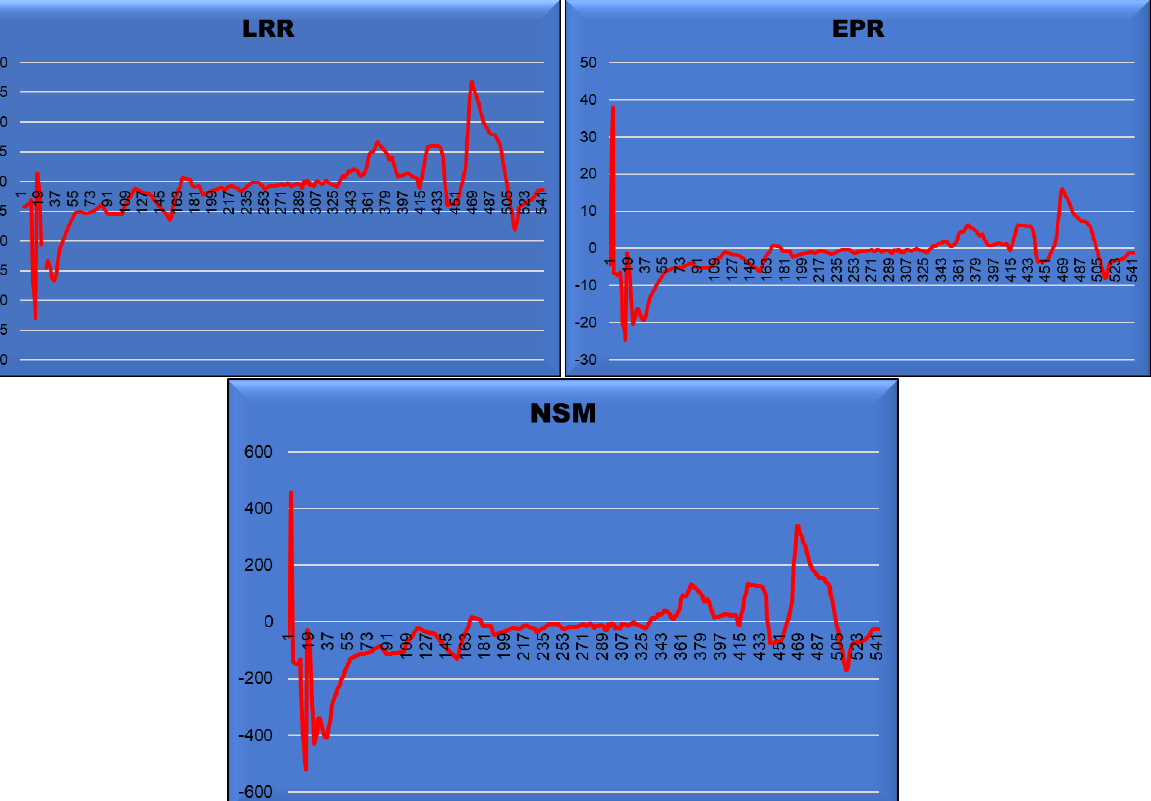
Figure 3. Graphical representation of the shoreline changes from 2000-2021 in Linear Regression Rate (LRR, m/year), End Point Rate (EPR, m/year), Net Shoreline Movement (NSM, m/period). Most of the areas falling below the line indicate shoreline